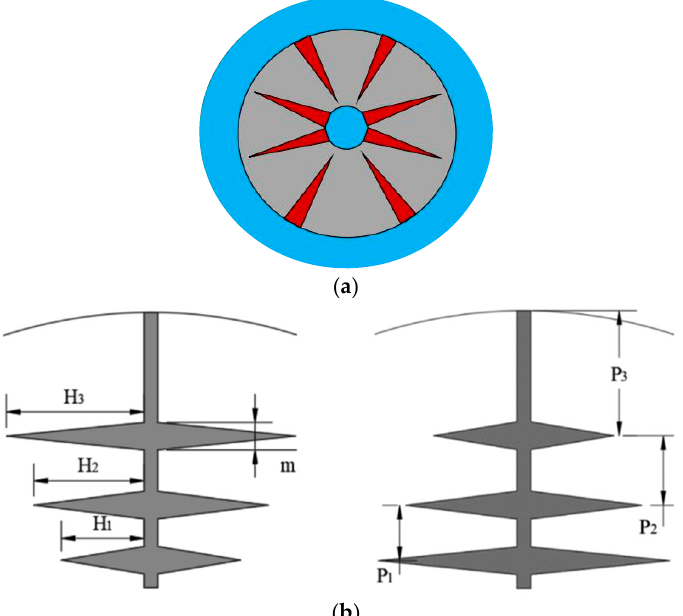
Figure 12. Different triangular fins. ( a ) Internal–external triangular fins [107]; ( b ) Longitudinal triangular fins [110]. (Permission to reproduce from Refs. [107,110]).